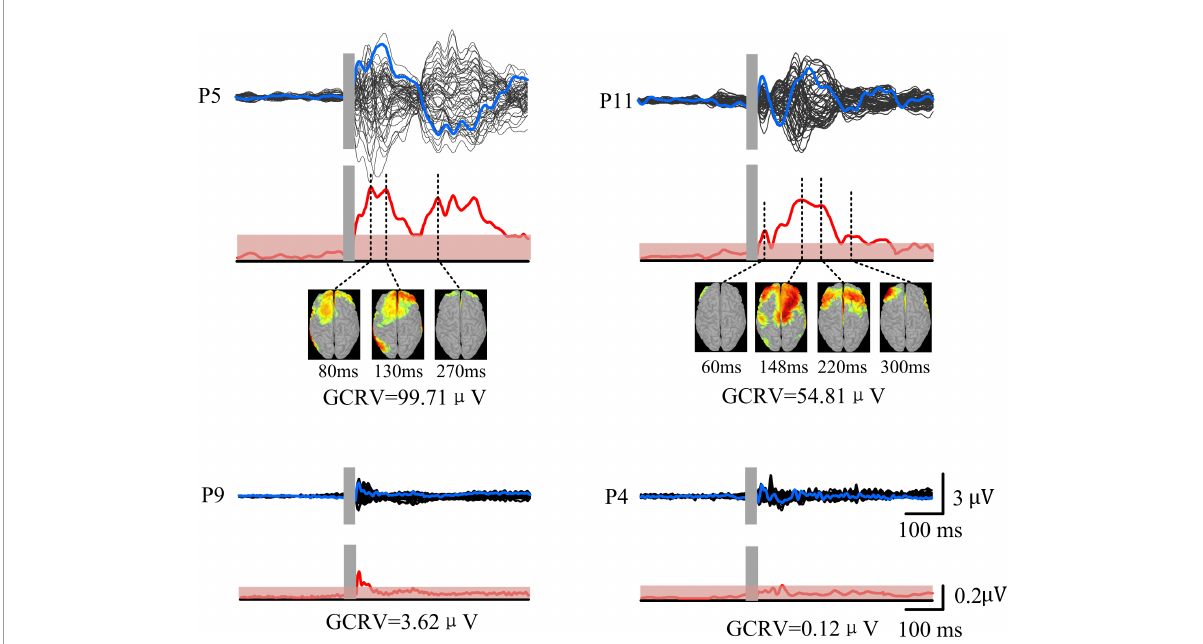
FIGURE3 TMS-EEG of four patients (P5, P11, P9, and P4). Black curves show butterfly plots of TEP at all electrodes. Blue curves show TEP at F3 electrode (near target site). GMFP (red curves) was calculated based on the TEP. Red shadows show threshold values for determining significance of GMFP with significance level at p < 0.01. Source model was performed at each peak of TEP.